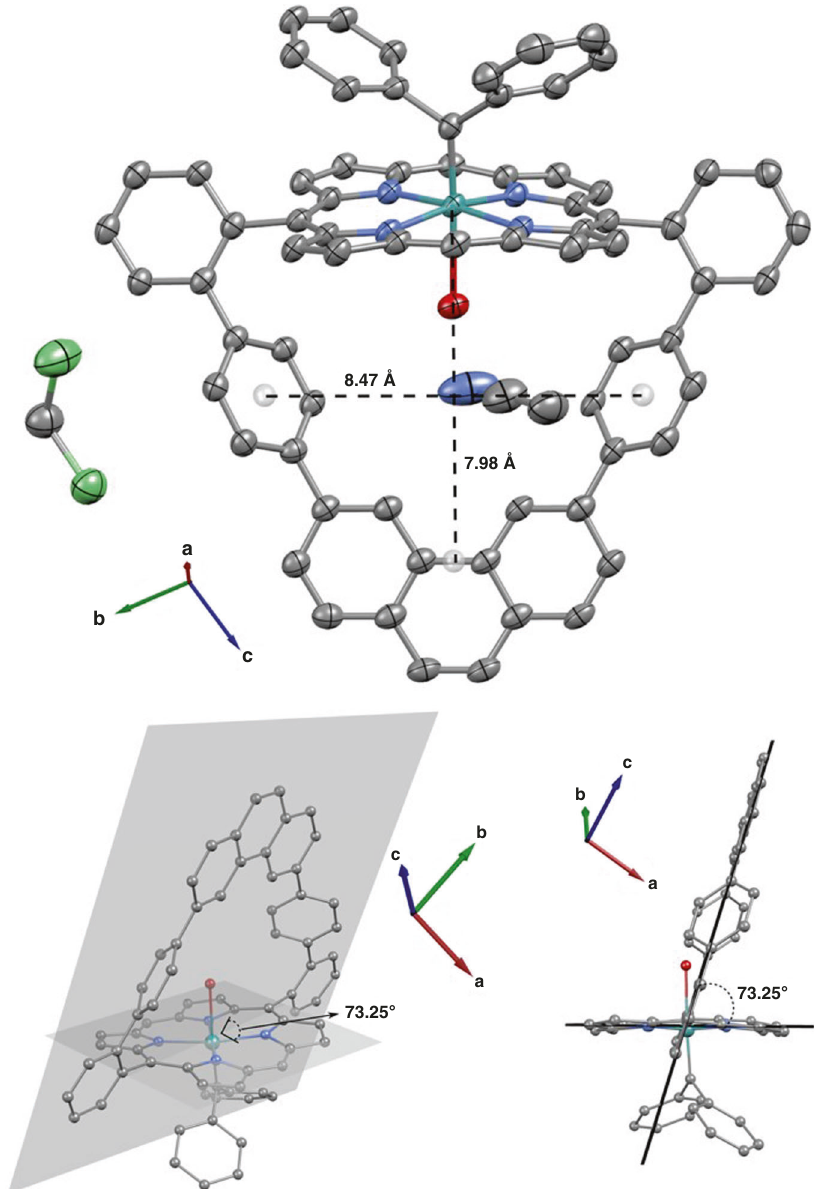
Fig. 4 Representation of the crystal structure of macrocycle 11. Single crystals were grown from a dichloromethane/acetonitrile saturated solution by slow evaporation. Carbon atoms are shown in gray, nitrogen in blue, oxygen in red, ruthenium in turquoise and chlorine in green. Hydrogen atoms are omitted for clarity purposes. Ellipsoids are drawn at 50% probability levels. CCDC ID